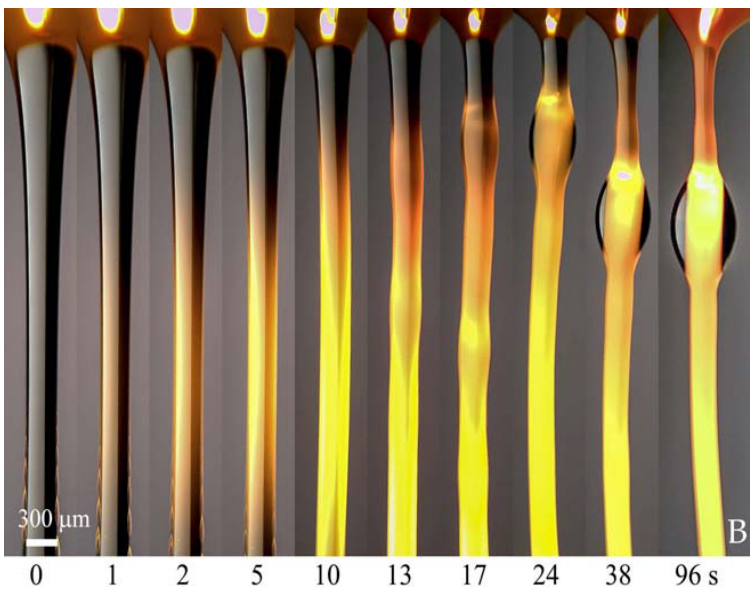
Figure 6. Phase separation at constant draw ratio for 7 wt. % of CPABI in DMAc+3% LiCl ( A ) and PAN solutions in DMSO ( B ). Appearing wavy jet shape and glow reflect inhomogeneity obliged to phase separation.